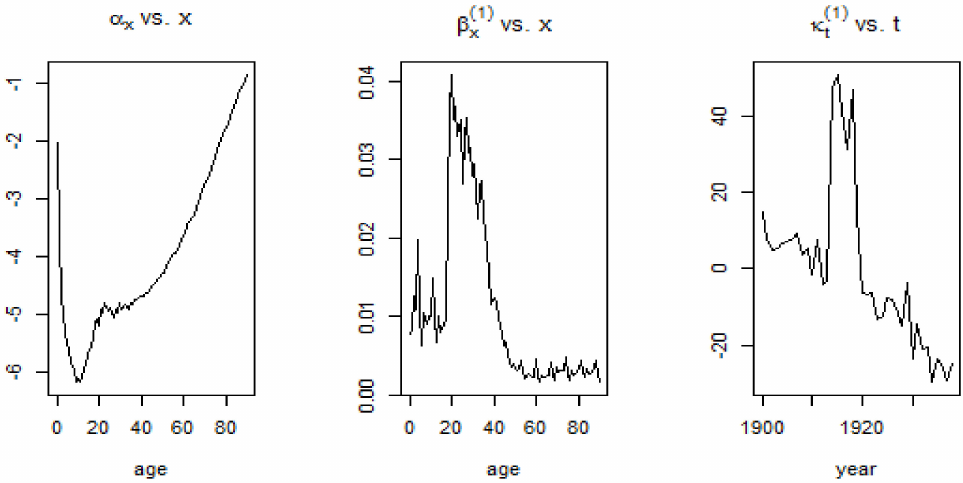
Figure 12. Estimation of the Lee-Carter parameters for the 1900–1938 period.